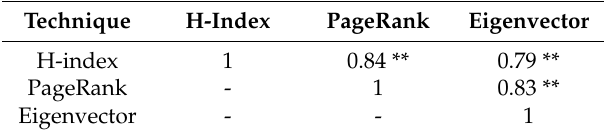
Table 7. Spearman correlation between PageRank, Eigenvector and the